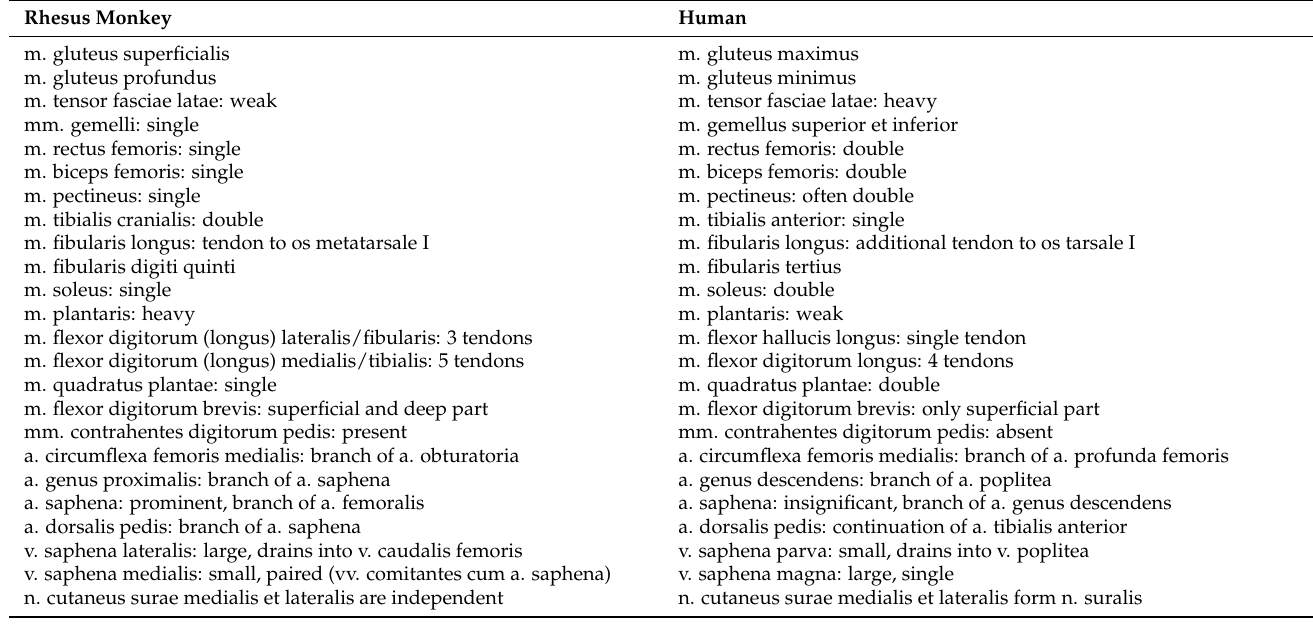
Table 2. Differences observed between the anatomy of the hindlimb of the rhesus monkey and the anatomy of the human